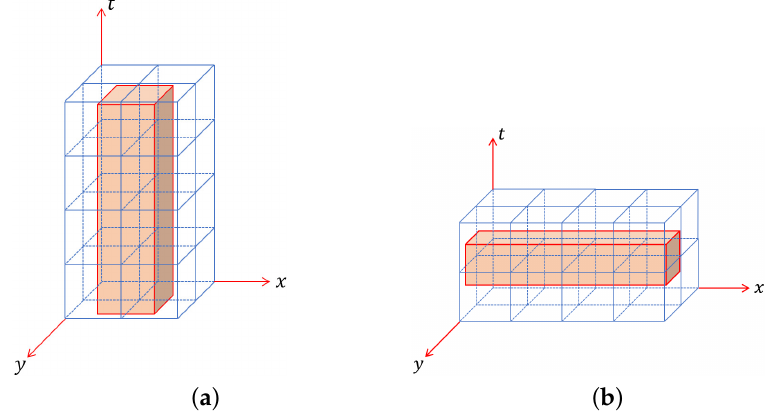
Figure 10. Spatio-temporal range query with unbalanced time and space dimension scales. ( a ) The query for a long time range and a small spatial range. ( b ) The query for a short time range and a large spatial